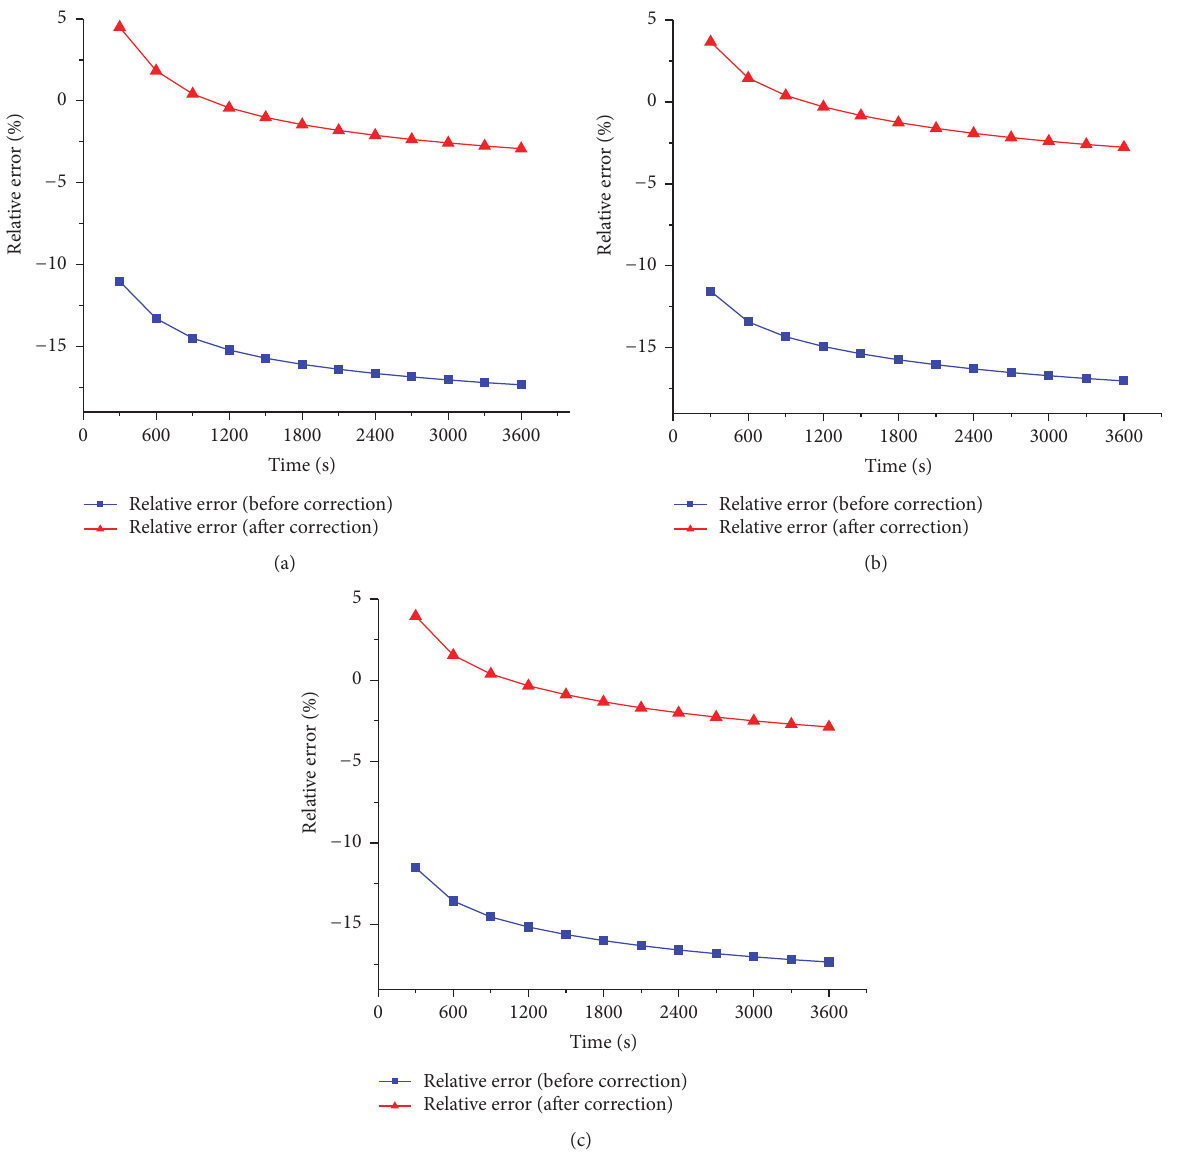
Figure 10: Comparison of relative error before and after correction at 40 ∘ C (a), 50 ∘ C (b), or 60 ∘ C